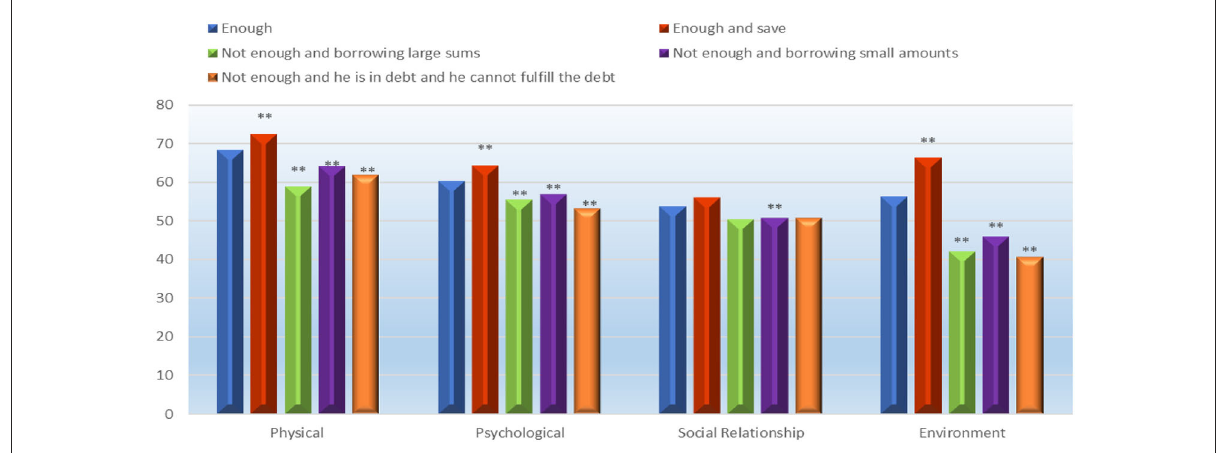
FIGURE3 One-way multivariate analysis of variance (MANOVA) in testing the effect of income on QoL different domains. Bonferroni’s method adjustments for the number of comparisons were applied. ** p <